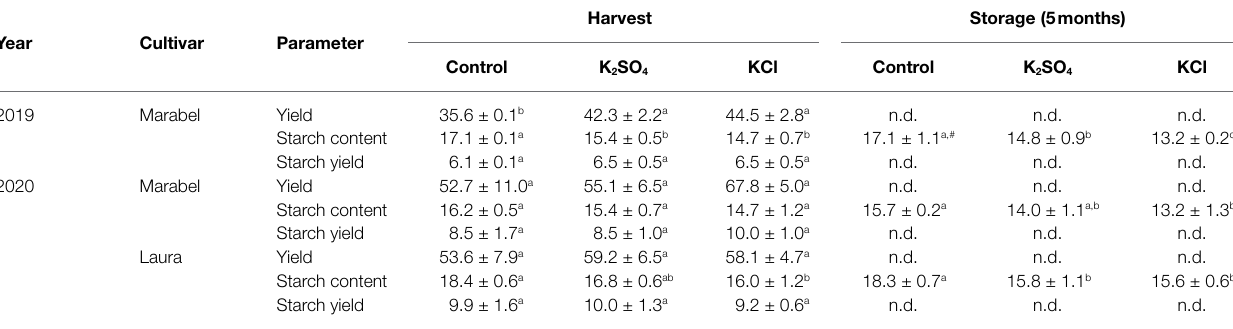
TABLE 1 | Yield (t ha − 1 ), starch content (% FM), and starch yield (t ha − 1 ) depending on fertilisation form, cultivar, year, and